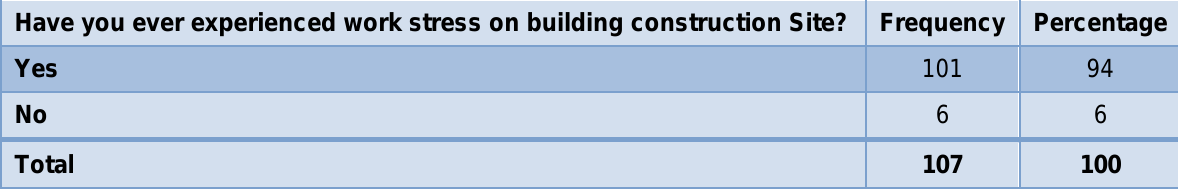
Table 4 Perception of work stress among the professional (Source: Field work,